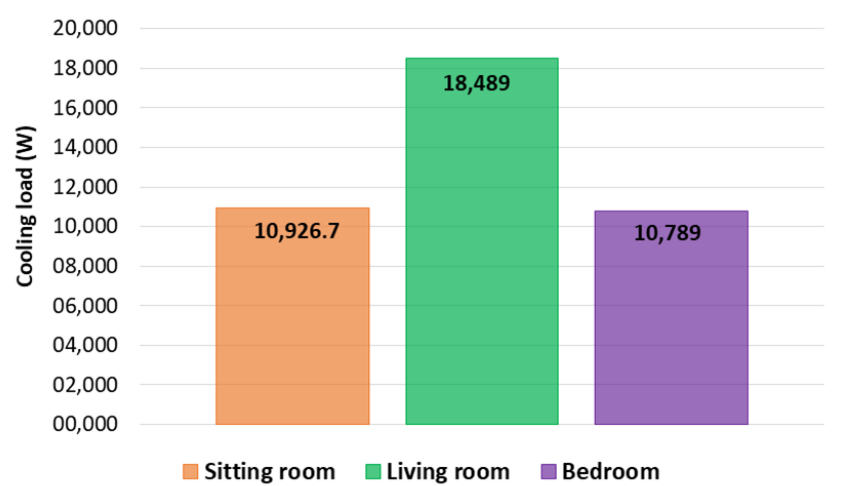
Figure 17. Daily cooling loads required in the monitored rooms.